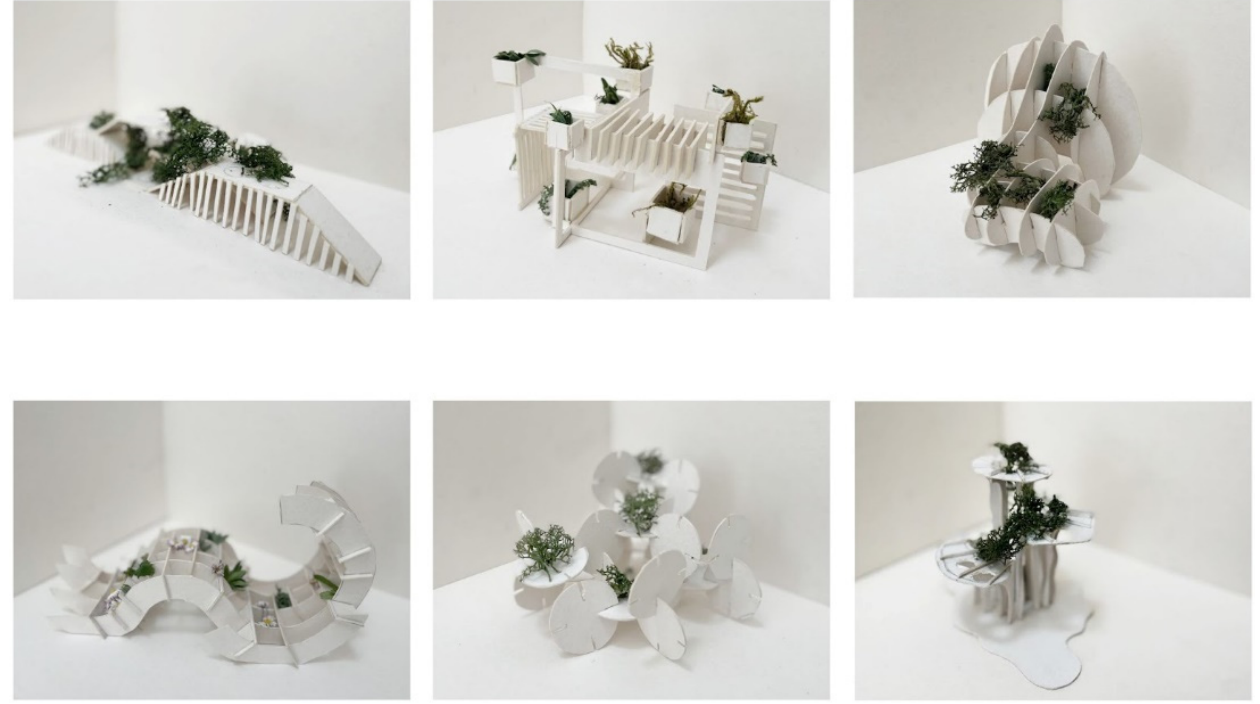
Figure 3. Propositions of the design